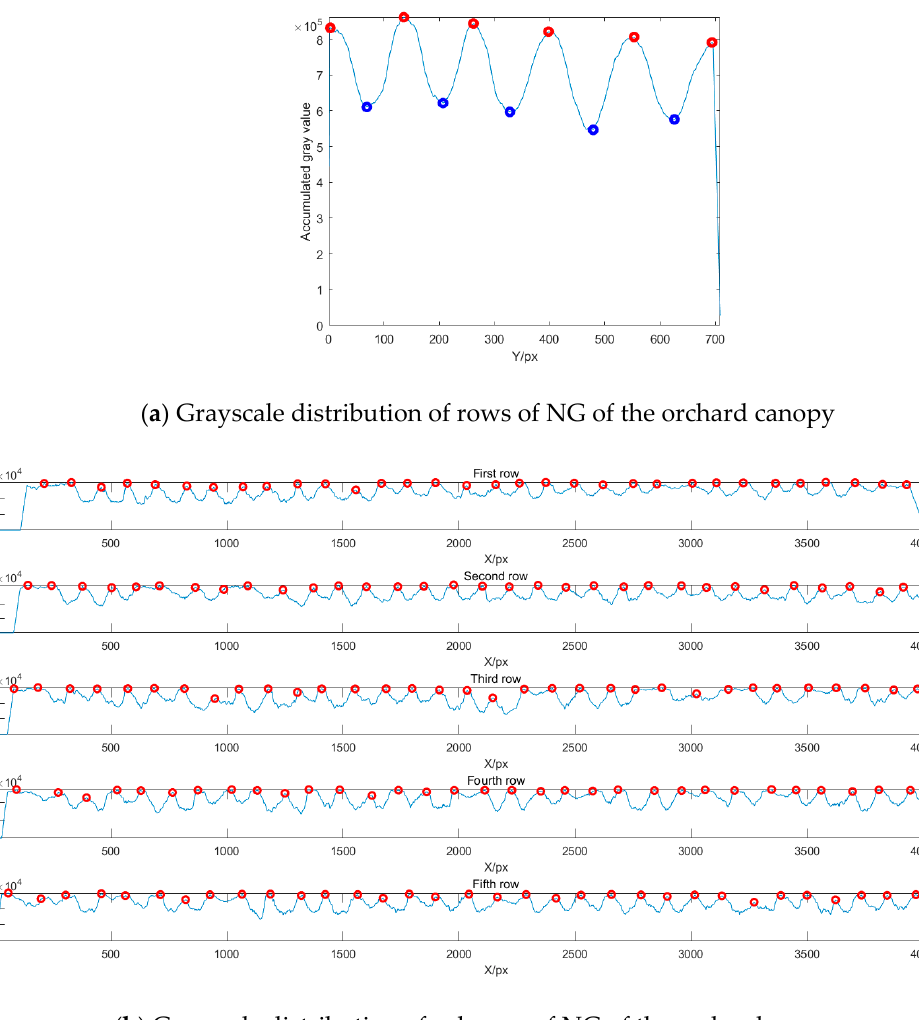
Figure 3. Row and column detection results with orchard canopy data.